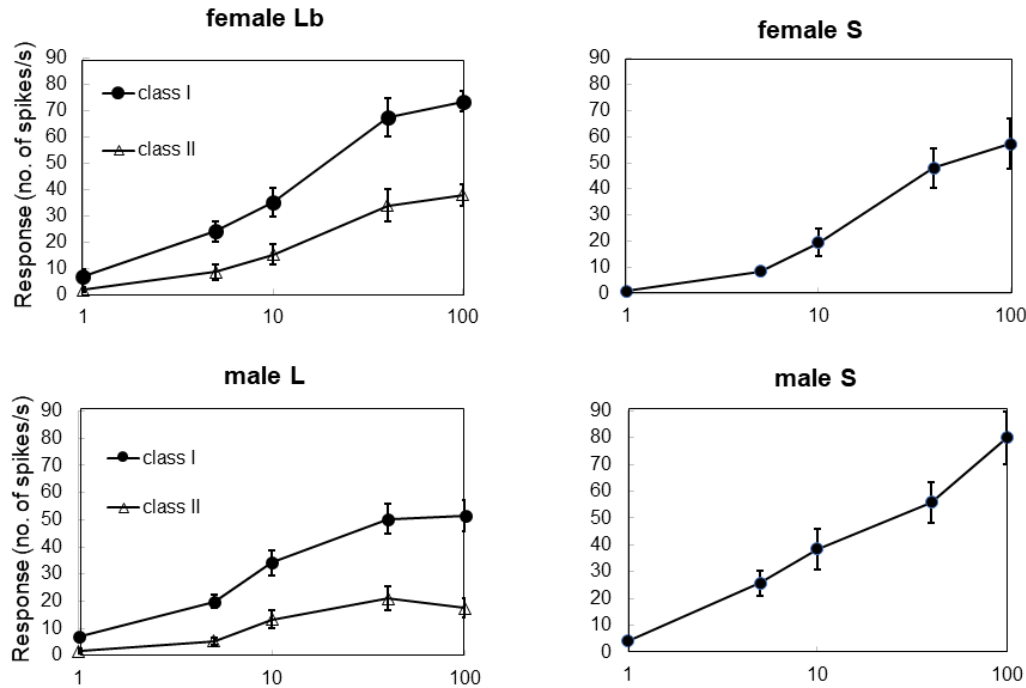
Figure 4. Dose dependency of response to sucrose in male and female sensilla. The responses were observed in both cells (class I and II) in female long-type sensilla b (female Lb) and male long-type observed in both cells (class I and II) in female long ‐ type sensilla b (female Lb) and male long ‐ type sensilla (male L) and for one cell in female short ‐ type sensilla (female S) and male short ‐ type sen ‐ sensilla (male L) and for one cell in female short-type sensilla (female S) and male short-type sensilla silla (male S) ( n = 6–21). (male S) ( n =